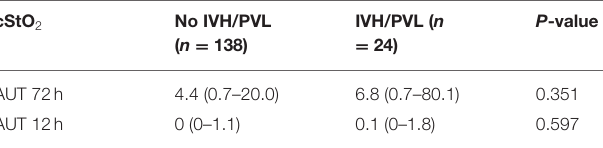
AUT, area under the threshold; cStO 2 , cerebral tissue oxygen saturation; IVH, intraventricular hemorrhage; PVL, periventricular leukomalacia.